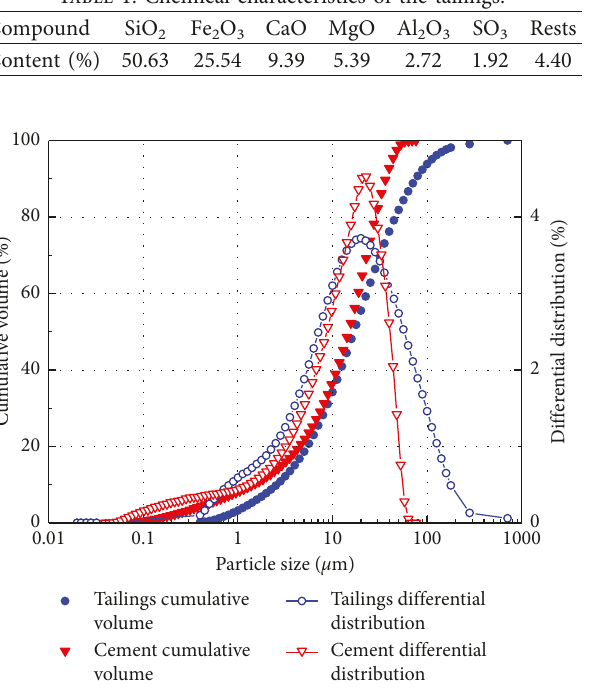
Figure 1: Particle size distribution of the unclassified tailings and cement. Table 2: Contents of the cement.